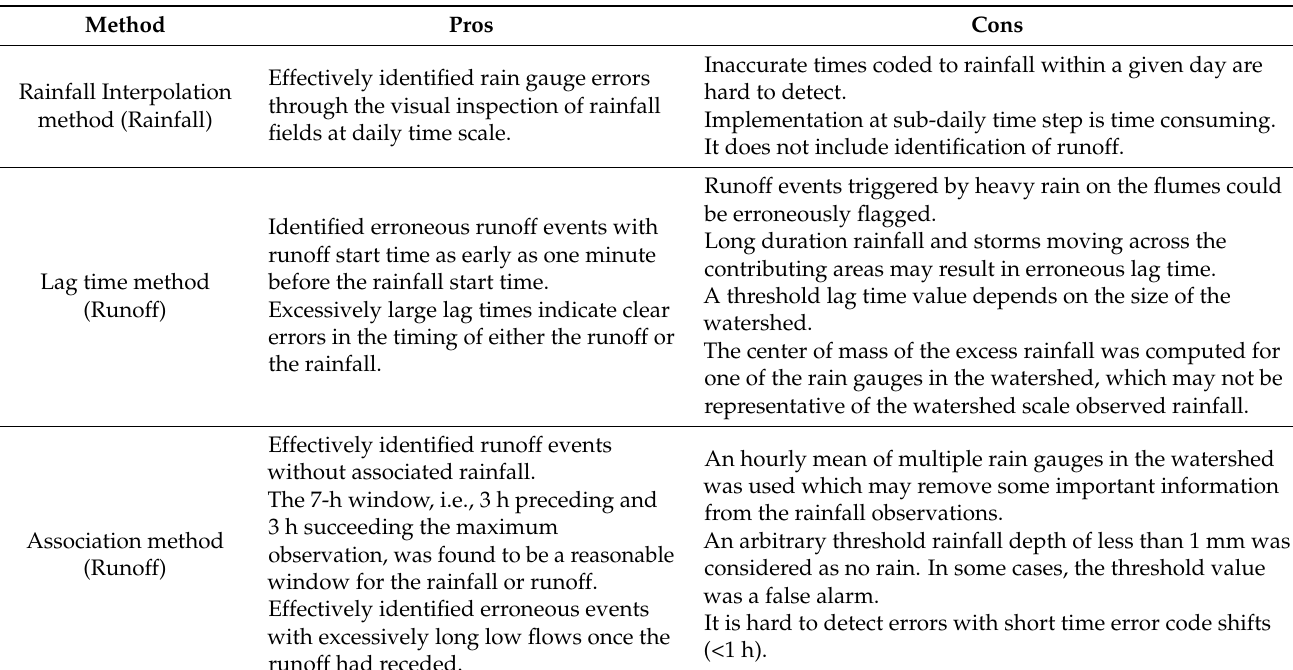
Table 1. Pros and cons of the four methods implemented for the runoff